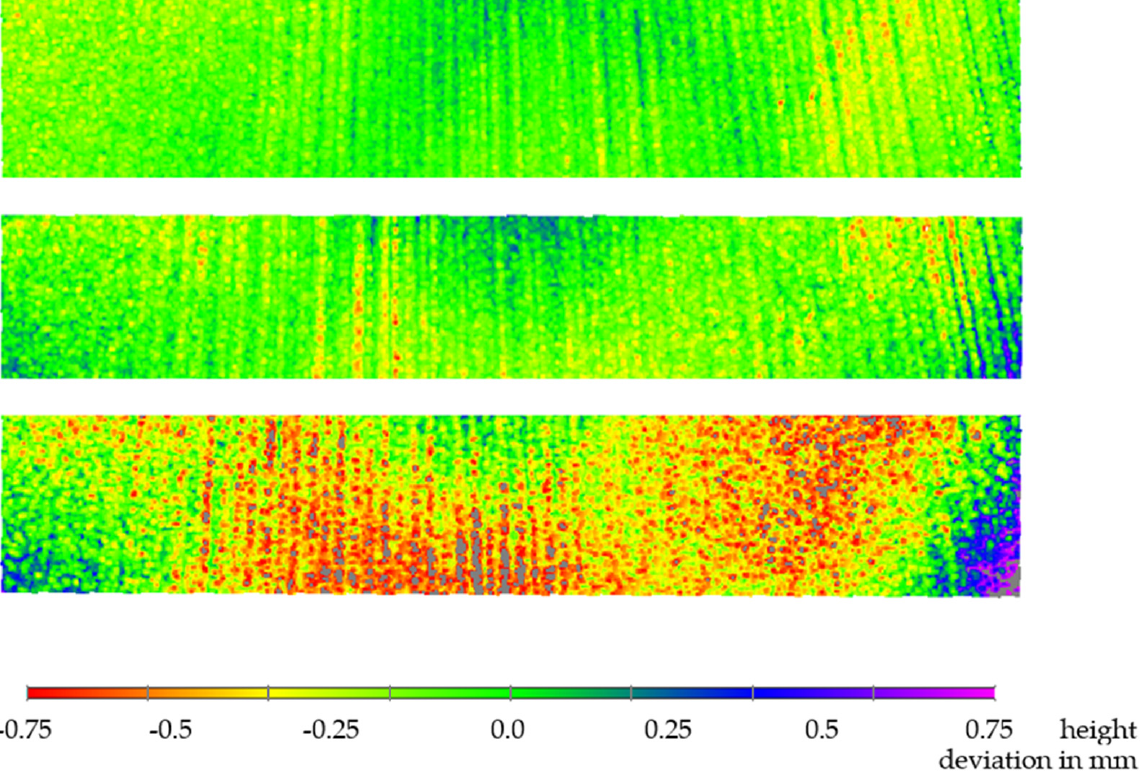
Figure 5. False-color representation of flatness deviation: measurement distance of 1.7 m ( above ), 2.0 m ( middle ), and 2.4 m ( below ). Table 2. Results of noise determination on sphere surfaces and plane normal depending on object distance; refinement does not have any influence on the noise values.